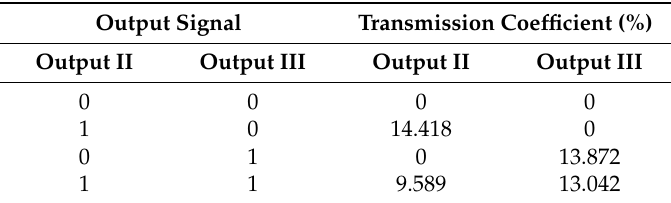
Table 1. Transmission coefficients of the Y-branch switch at different logical states.